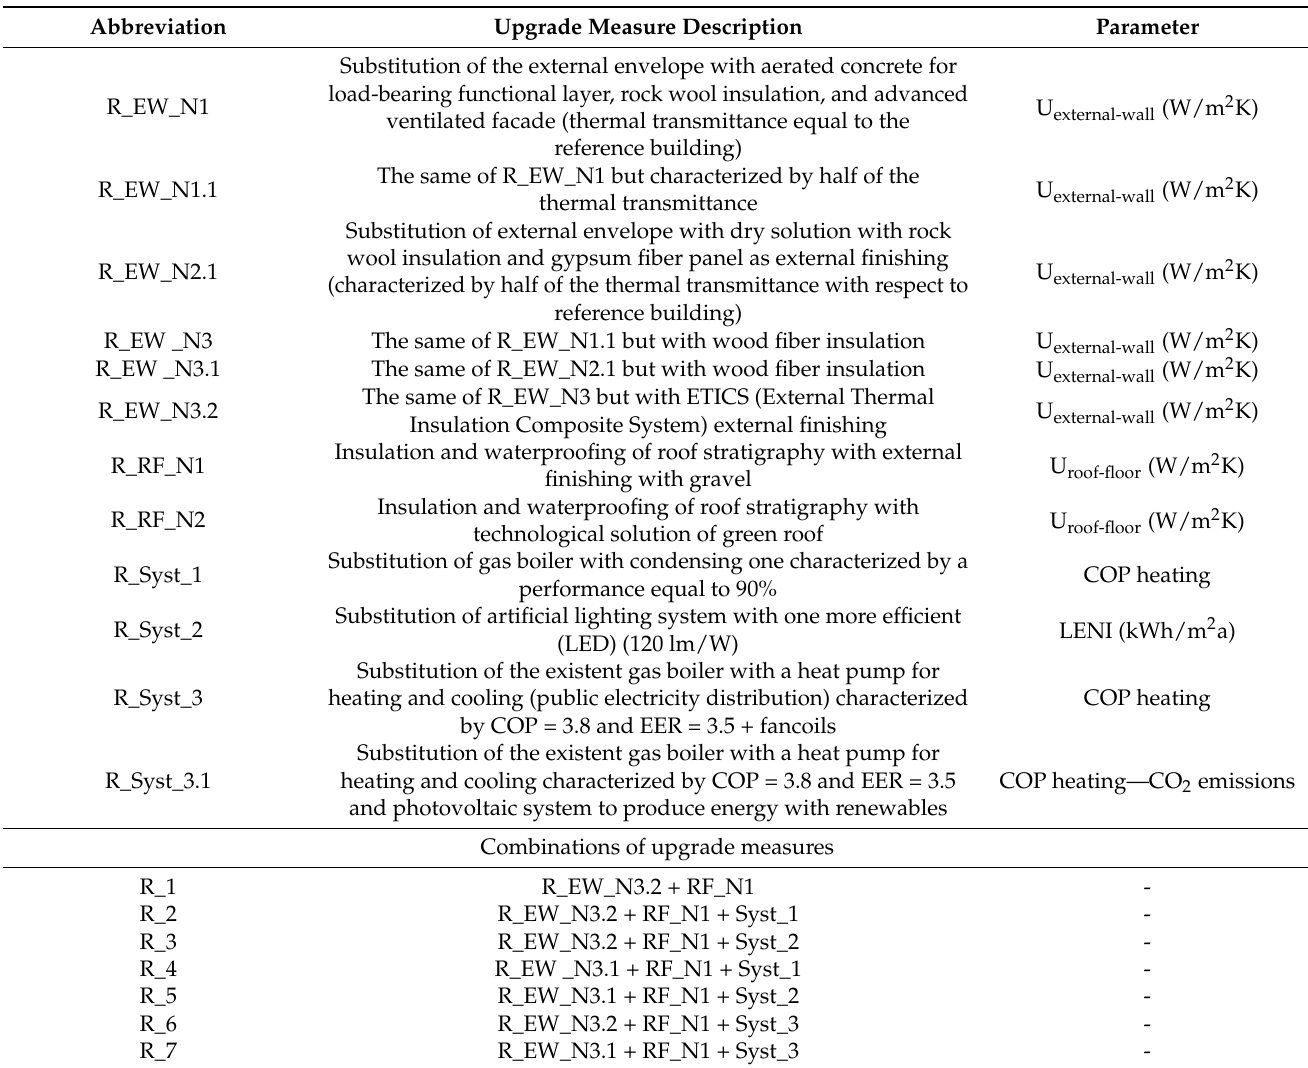
Table 2. Different upgrade measures and combinations of them for cost-optimal analysis applied to Rodari school. In the table, R stands for Rodari, EW means external wall, RF roof floor, Syst stands for system, N for new, U means the thermal transmittance, COP means the coefficient of performance, EER stands for energy efficiency ratio, and LENI stands for Lighting Energy Numeric